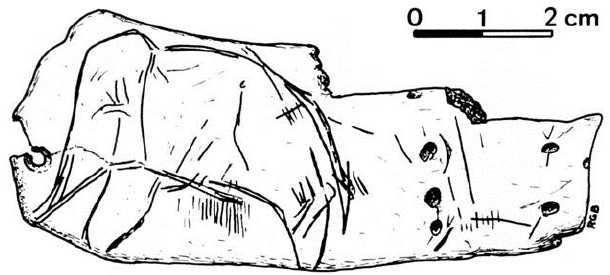
Figure 7. Presumed mammoth engraving on a perforated ivory plaque from Mal’ta, central Siberia.